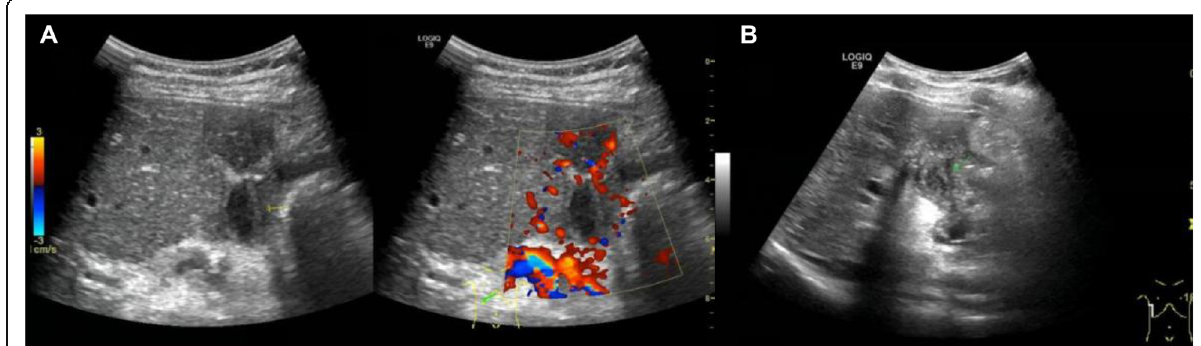
Fig. 1 Color Doppler ultrasonography of an 8-year-old girl after Rex-bypass operation for CTPV. No blood flow signal was found in the bypass vessels, and thrombosis was observed. a 7 days after operation. b 6 months after operation